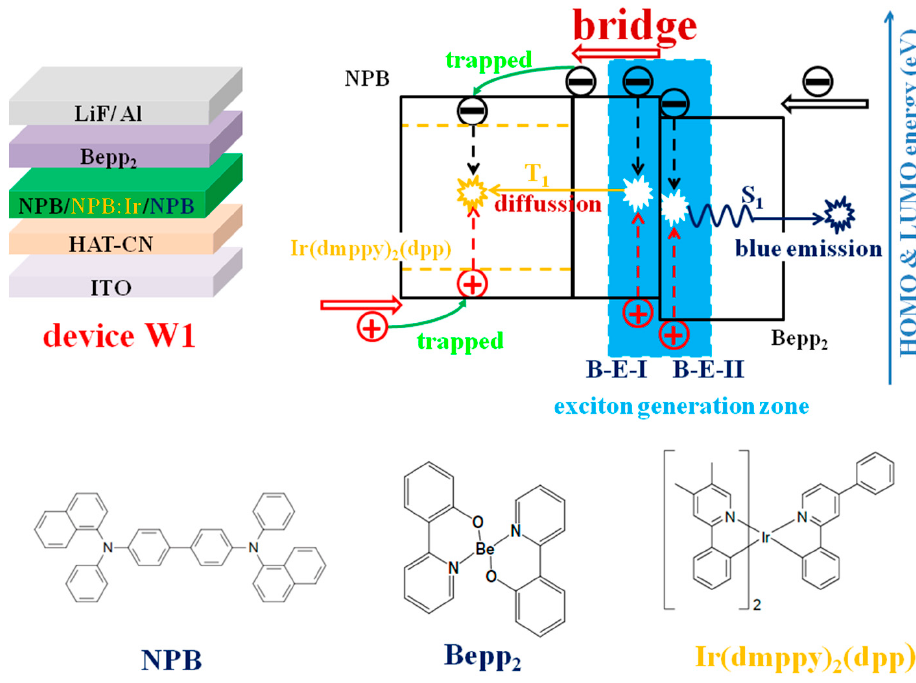
Figure 23. The WOLED architecture, emission mechanism, and emitters chemical structures.